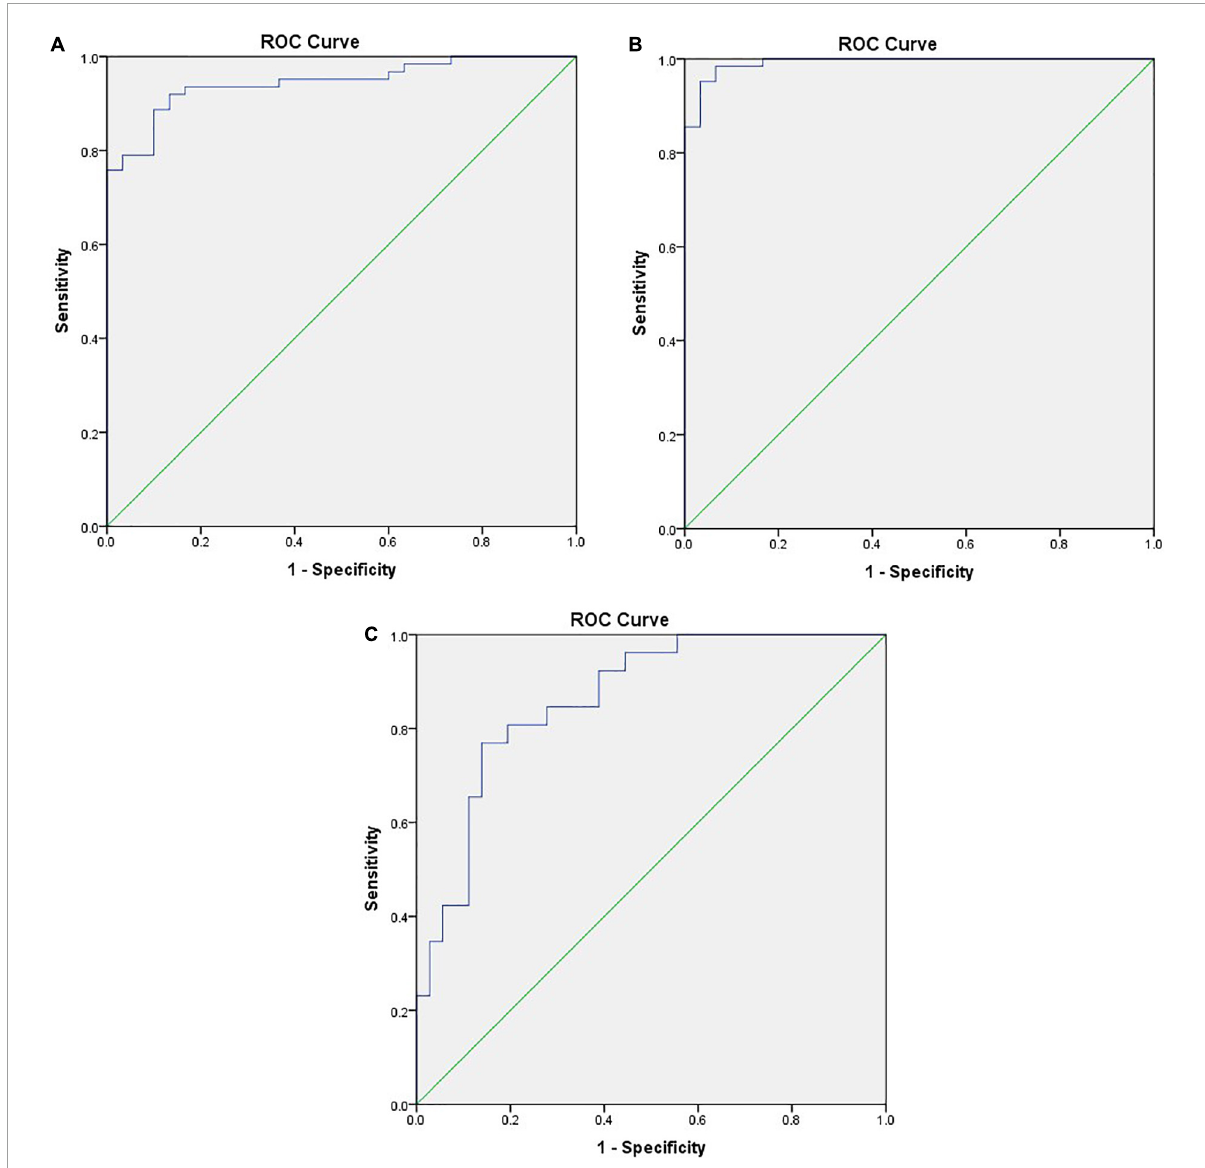
FIGURE4 (A) ROC curve between DTD and NG differentiated by STE-Mean, the positive actual state is DTD. (B) ROC curve of DTD and NG differentiated by flow velocity of superior thyroid artery, the positive actual state is DTD. (C) ROC curve of GD and HT differentiated by flow velocity of superior thyroid artery, the positive actual state is